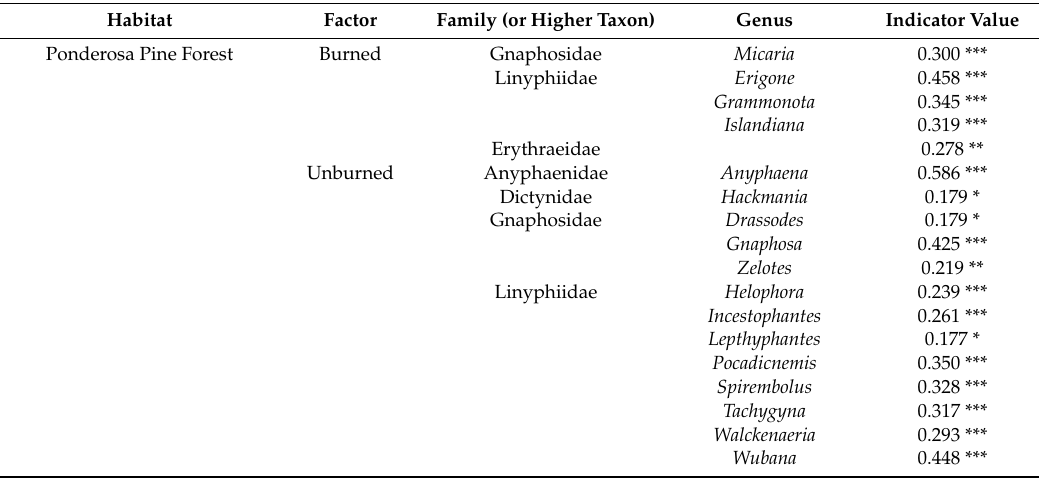
Table 4. Indicator taxon analysis of arachnids for treatment and year for Ponderosa Pine Forest, Mixed-coniferForest,andMountainValleyGrasslandatVallesCalderaNationalPreserve.